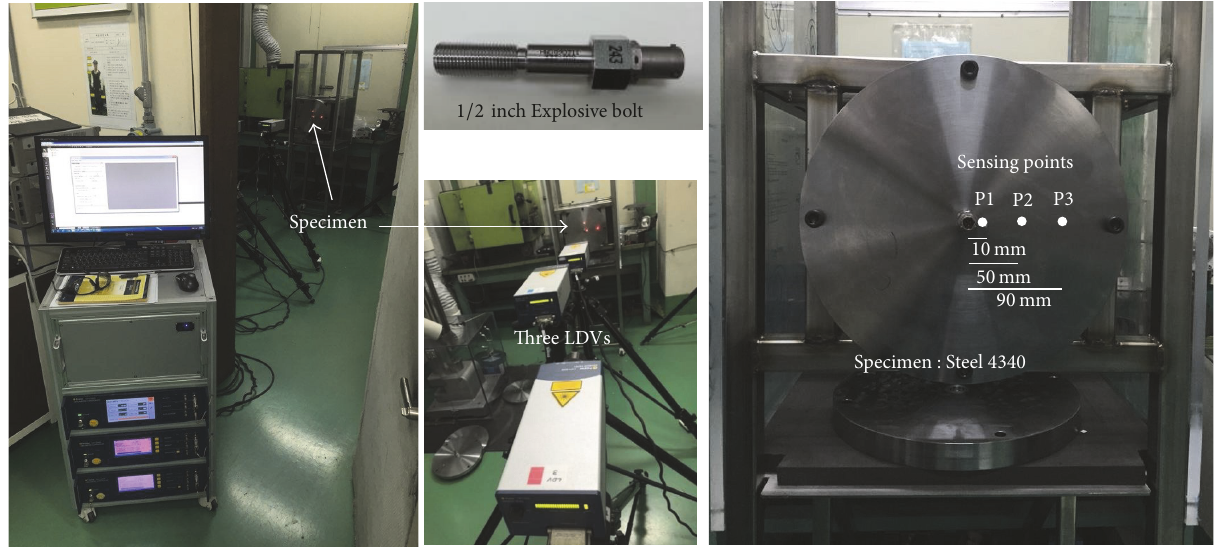
Figure 21: Measurement system of point explosive-induced pyroshock and the disk type specimen.